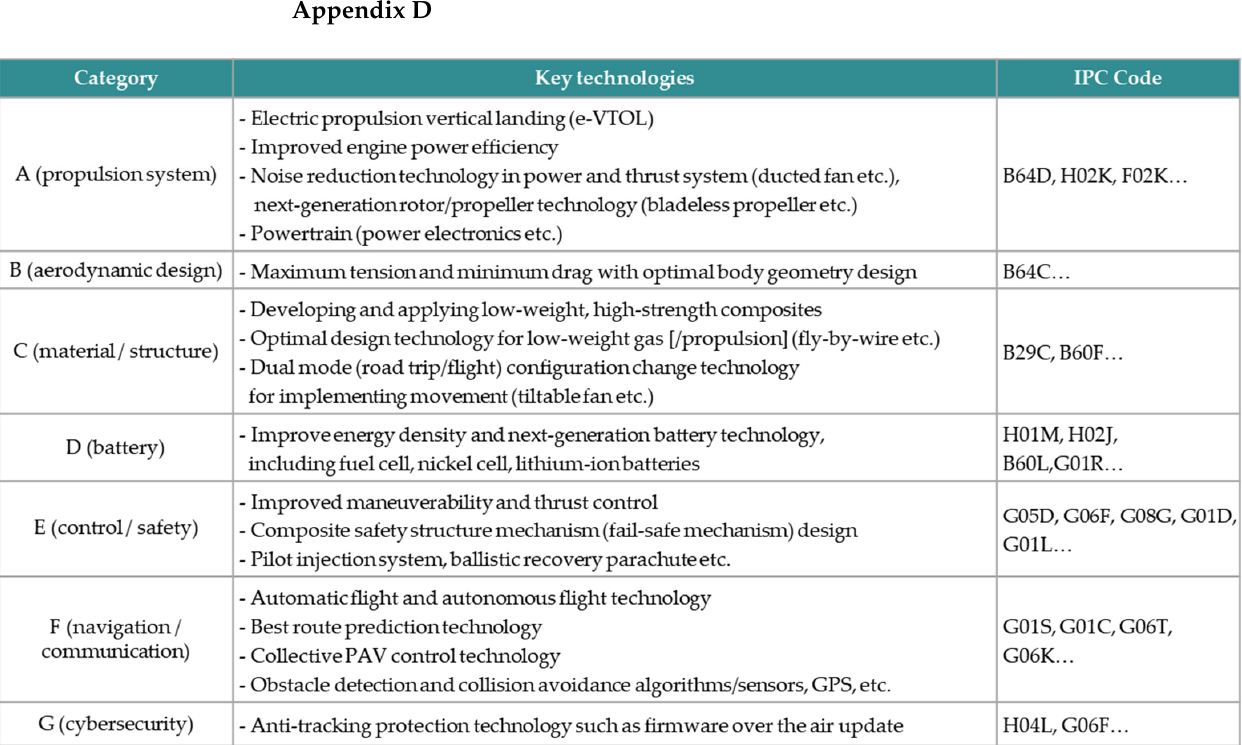
Figure A4. UAM Tech ‐ Tree.